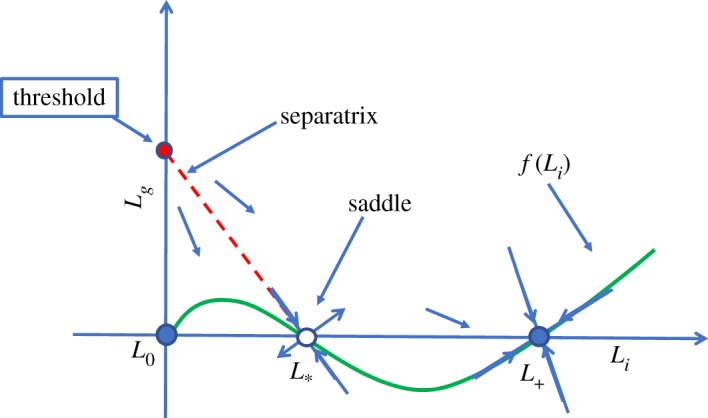
Threshold approximation. The extension of the eigenvector, emanating from L*, to the Lg-axis approximates the separatrix of the two basins.